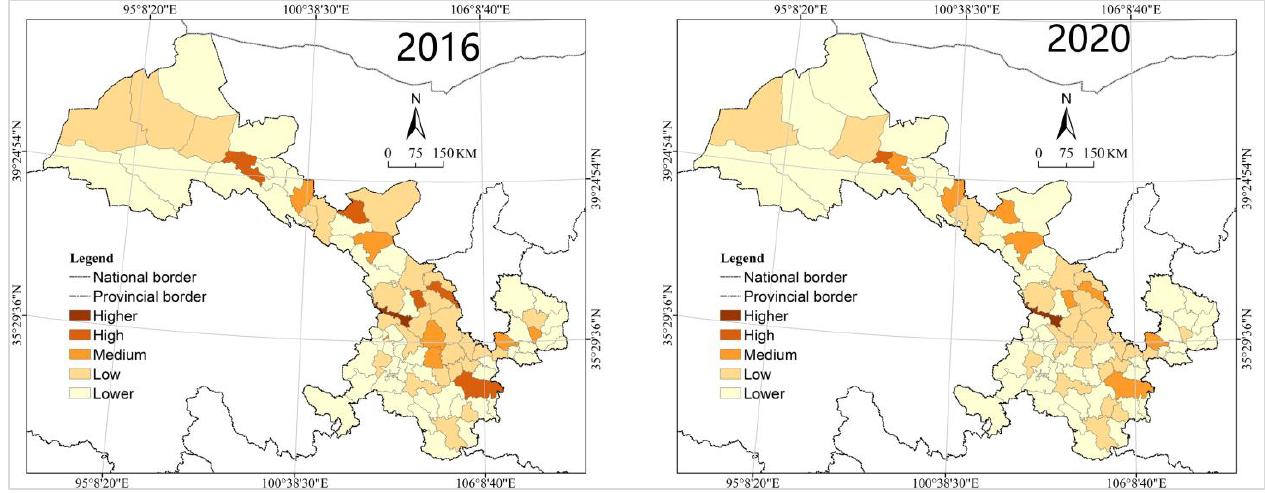
Figure 5. Analysis on the spatial clustering of urban construction land scale in Gansu.